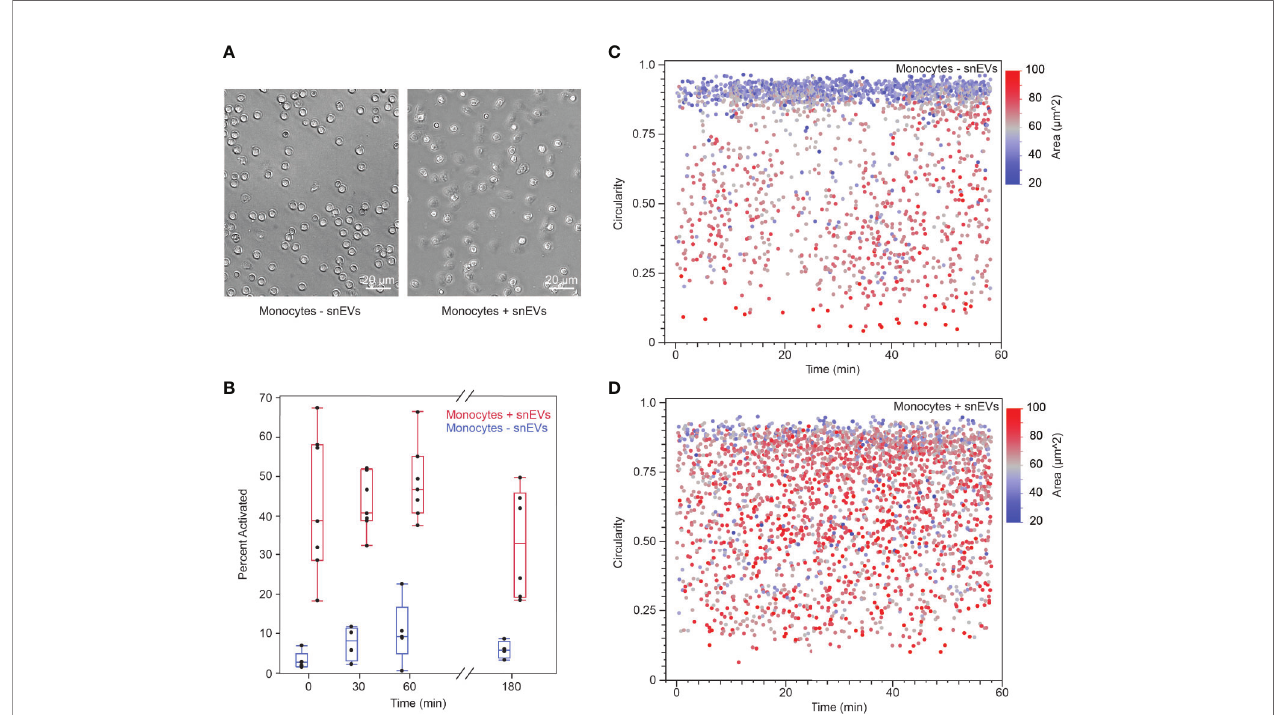
FIGURE 6 | (A) Non-activated monocytes (-snEVs, left) had a spherical morphology and did not attach to the substrate. When snEVs were added, the monocytes became activated, developed pseudopods, and adhered to the substrate (scale bars: 20 µm) (B) Upon the addition of snEVs, monocytes became activated immediately (42.7% ± 18.0%, N = 7 for t = 0 min). This activation remained approximately constant throughout the fi rst hour after snEV addition but began to decrease by 3 h (54.9% ± 7.9%, 48.3% ± 9.6%, 32.8% ± 13.8%, for t = 30, 60, and 180 min, respectively. p = 0.01 between t = 60 and 180 min). Monocytes without snEVs present exhibited some spontaneous activation in the fi rst 0.5 h of the experiment (p = 0.027 between t = 0 and 30 min), which remained approximately constant throughout the experiment (8.3% ± 4.5%, 10.5% ± 7.8%, 6.0% ± 2.2%, for t = 30, 60, and 180 min, respectively). However, this activation was signi fi cantly lower than that of monocytes + snEVs at each time point (p < 0.05). (C) Non-activated (- snEV) monocytes were spherical, which could be quanti fi ed as high circularity and relatively low 2D area (0.747 ± 0.2318 circularity and 584 ± 137 µm 2 , respectively). (D) In the presence of snEVs, monocytes underwent a morphological change, decreasing their circularity and increasing their area (0.655 ± 0.217 circularity and 695 ± 134 µm 2 , p <